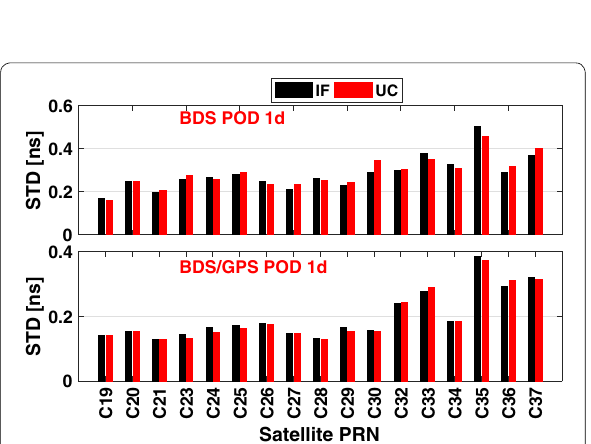
Fig. 8 Average clock accuracy of each BDS-3 satellite (S1–S4)